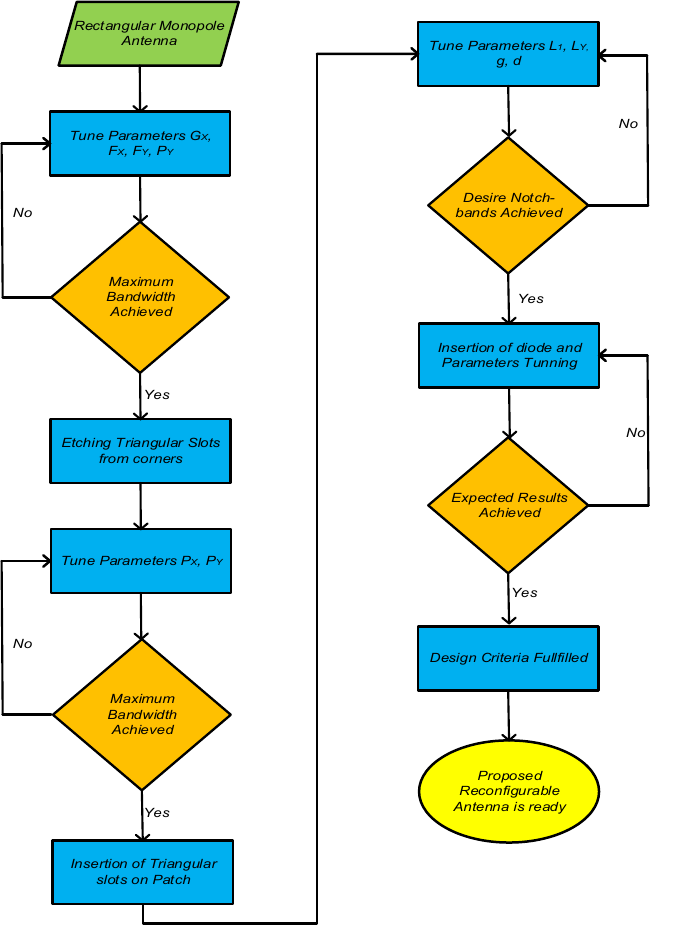
Figure 7. Flow chart of the design methodology of the proposed antenna.